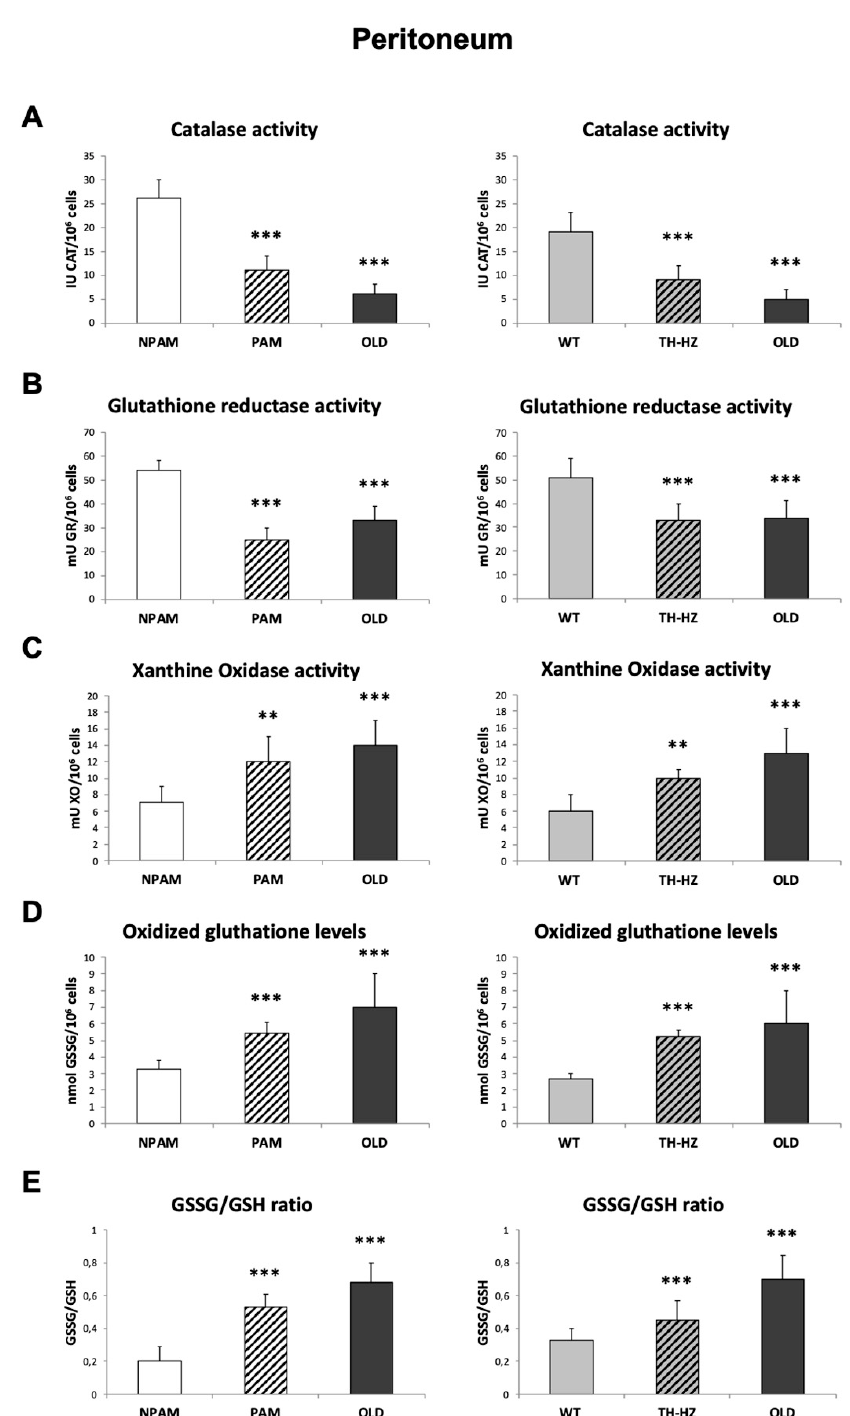
Figure 1. Parameters of redox state in peritoneal leukocytes. Anti-oxidant defenses: activity of catalase (CAT) (IU CAT/10 6 cells) ( A ) and glutathione reductase (GR) (mU GR/10 6 cells) ( B ); oxidants: activities of xanthine oxidase (XO) (mU XO/10 6 cells) ( C ), concentrations of oxidized glutathione (GSSG) (mmol GSSG/10 6 cells) ( D ), and redox balance (GSSG/GSH ratios) ( E ) in peritoneal immune cells from adult PAM, NPAM, TH-HZ, WT mice, and chronologically old animals. PAM: prematurely aging mice, NPAM: non-prematurely aging mice, TH-HZ: tyrosine hydroxylase hemi-zygotic mice, WT: wild-type mice. Each column is the mean ± SD of the values of 10 experiments corresponding to 10 animals. ** p < 0.01, *** p < 0.001 with respect to the corresponding controls.